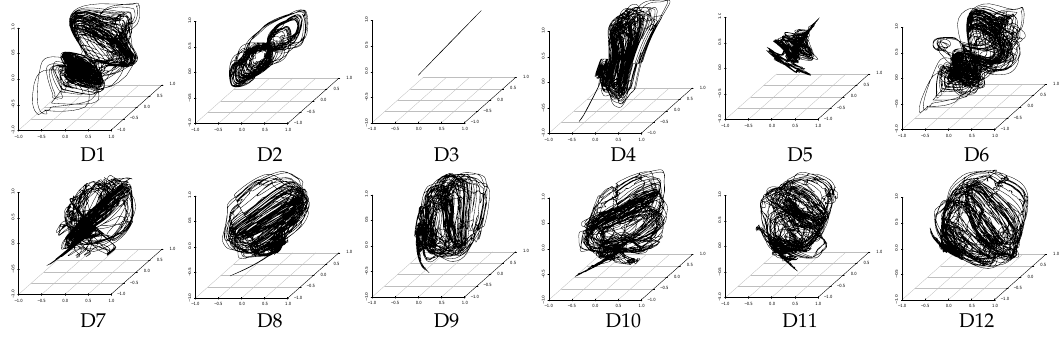
Figure 6. Three-dimensional time-series of latent features extracted from datasets D1 to D12 by DSAE in the three-dimensional feature